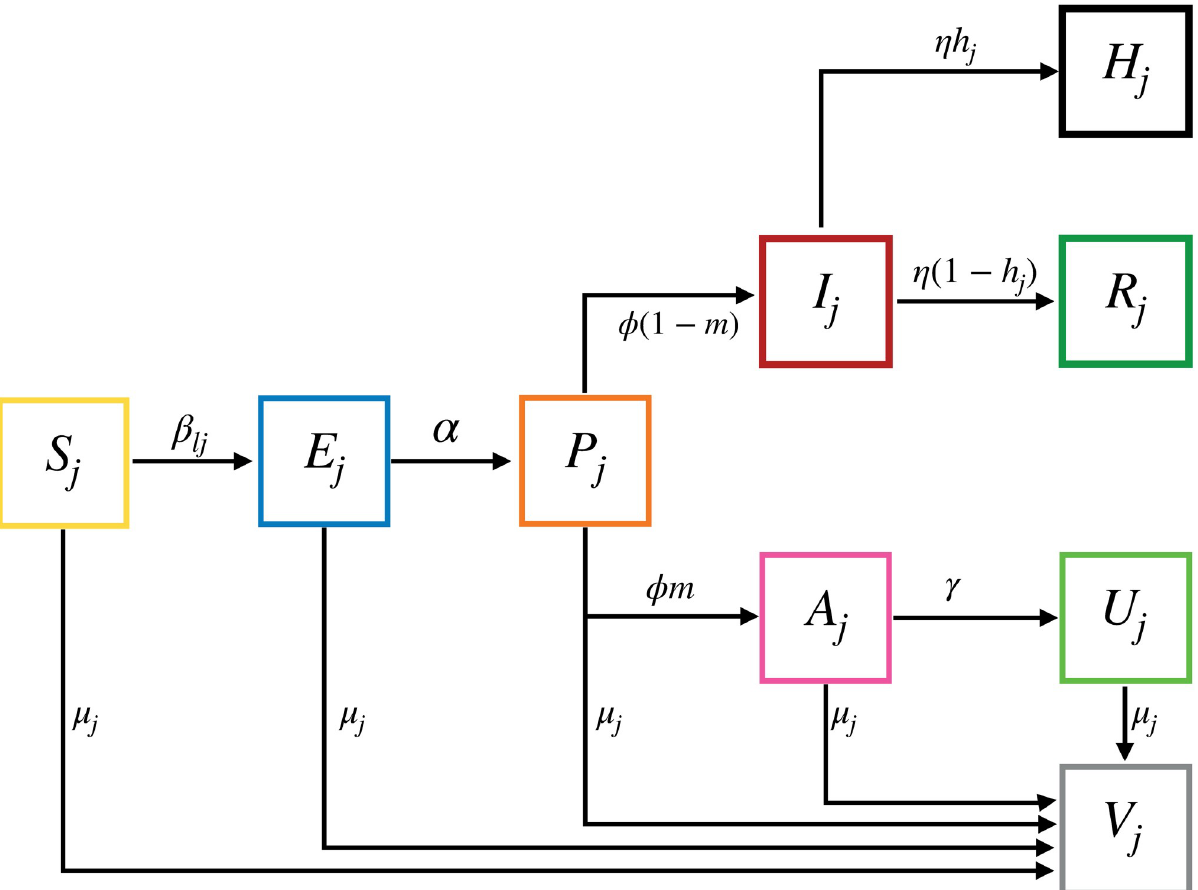
Fig 1. Model description. Individuals transition between states with rates specified by Greek letters. Small Latin letters are probabilities. Subscripts j and l depict age groups. Individuals start at a susceptible state ( S ) and upon infection with an age-dependent rate β After an incubation period of 1/ α days individuals become presymptomatic ( P ) for 1/ ϕ days and infectious. The disease can then progress to be either asymptomatic ( A ) with a probability m , or symptomatic ( I ). Symptomatic individuals are identified and removed to quarantine ( R ) within 1/ η days or, with a given age-dependent probability h j develop severe symptoms and go to the hospital ( H ). Asymptomatic individuals naturally recover ( U ) within 1/ γ days. All individuals that do not show symptoms can get a vaccine ( V ) at a constant rate of μ vaccines per day. See Methods for a comprehensive description of the model equations, parameters and vaccination strategies. See examples of model run in (S1 and S2 Figs).